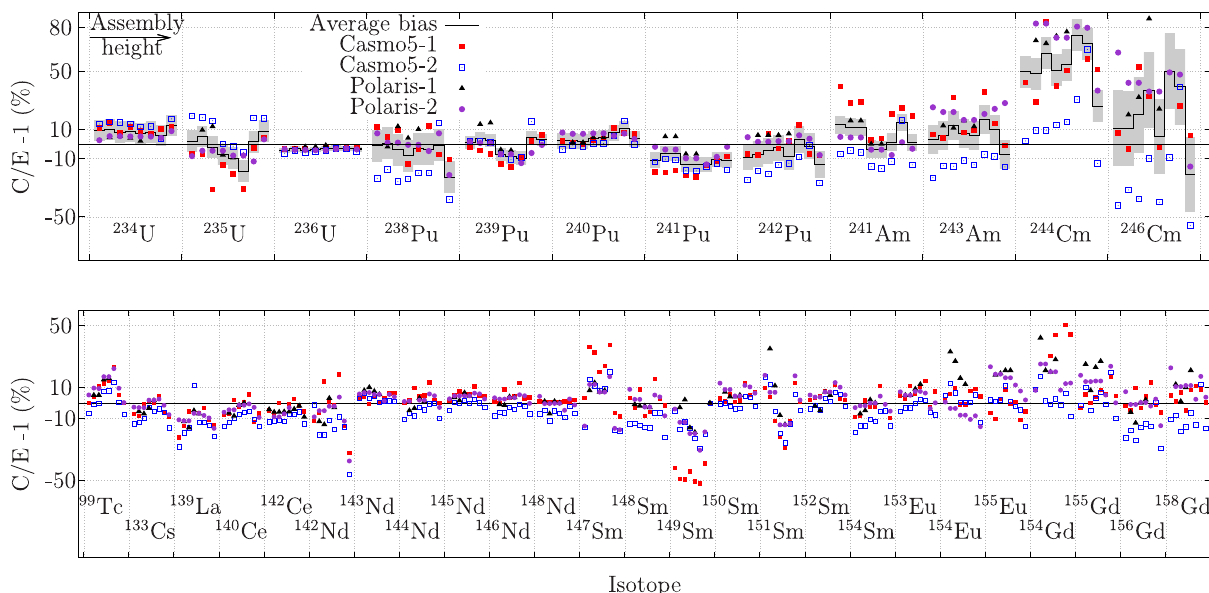
Fig. 2. Comparison for calculated and measured nuclide concentrations between the four types of calculations (top: actinides, bottom: fission products). In each subbox, data are ordered from left to right as a function of the sample vertical